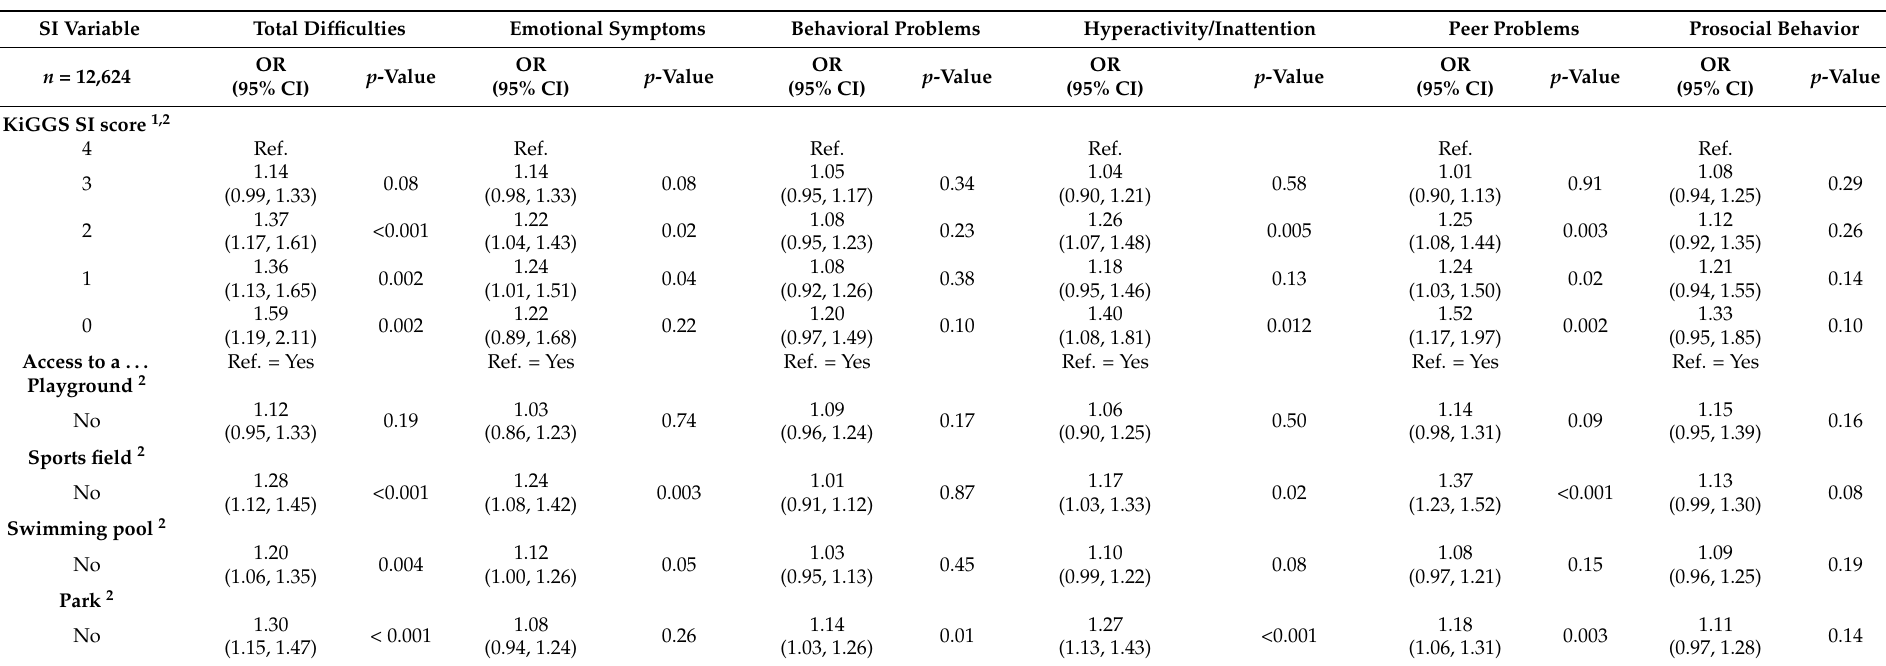
Table 2. Multivariable analyses of the association between social infrastructure and children’s and adolescents’ mental health within the full